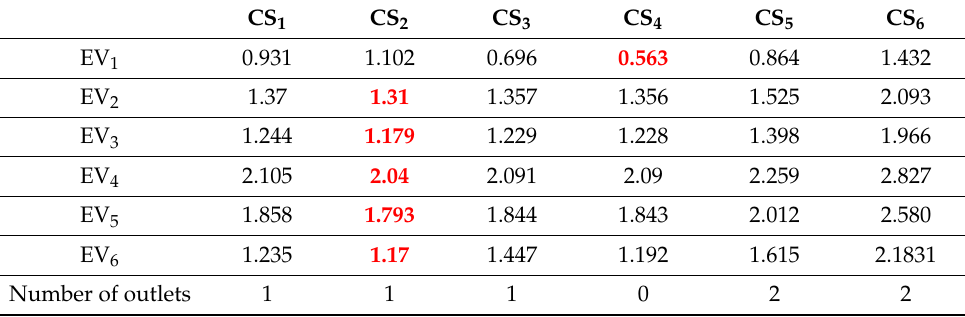
Figure 11. Assignment of EVs according to the shortest way.